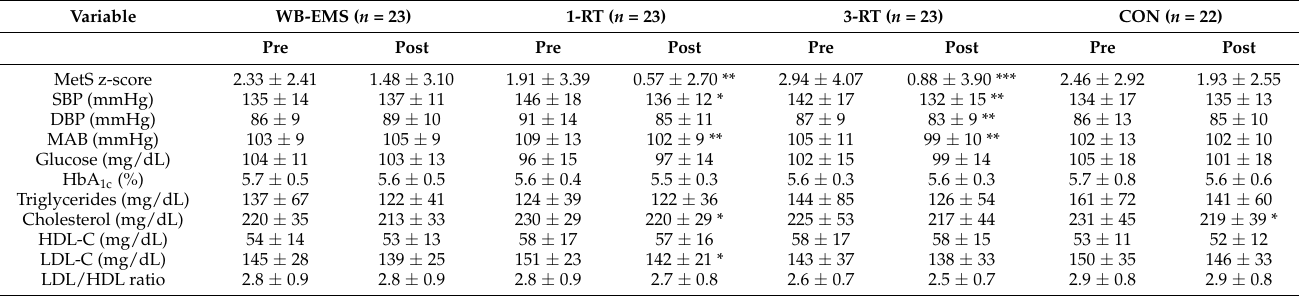
Figure 3. Changes in the metabolic syndrome z-score. ** ( p < 0.01), *** ( p < 0.001): significantly different from pre-intervention. Table 4. Cardiometabolic risk variables pre- and post-intervention.